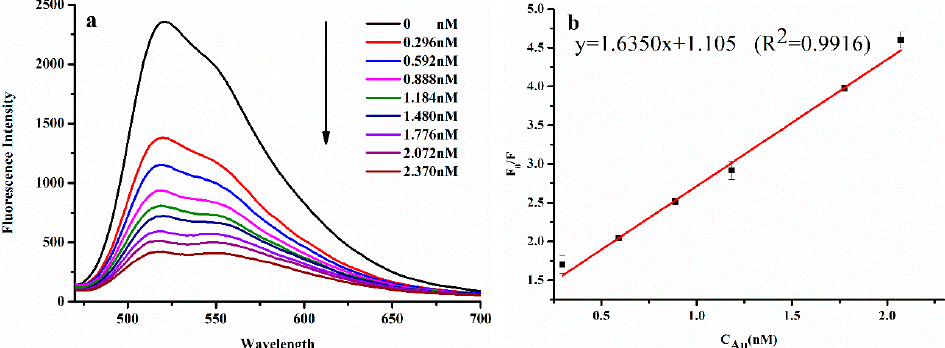
Figure 2. ( a ) Fluorescence emission spectra of CPNs with the increased concentrations of AuNPs; ( b ) the linear fitting plot of F 0 /F values at 520 nm versus AuNPs concentrations from 0 to 2.370 nM, CPNs: 0.187 μ M.